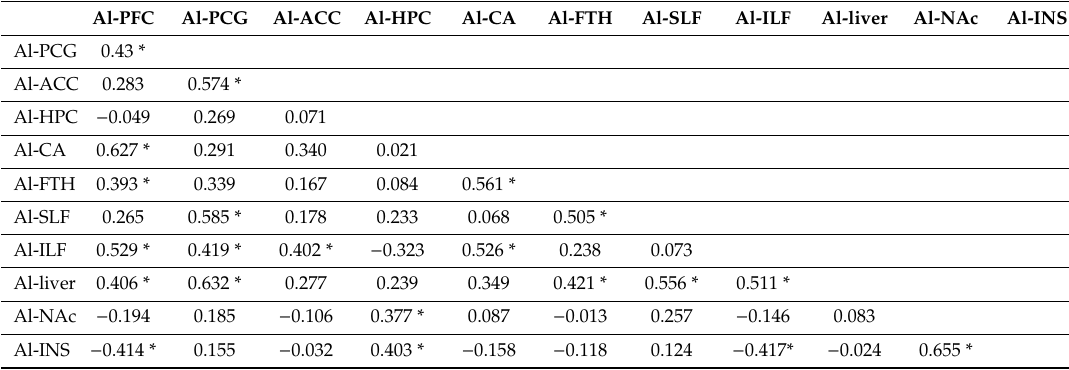
Table 3. Spearman correlation coe ffi cient for Al content in various brain structures and the liver of AUD subjects. Asterisks indicate p < 0.05 analysis of Al concentration. Correlation coe ffi cients marked with * are significant at p < 0.05.